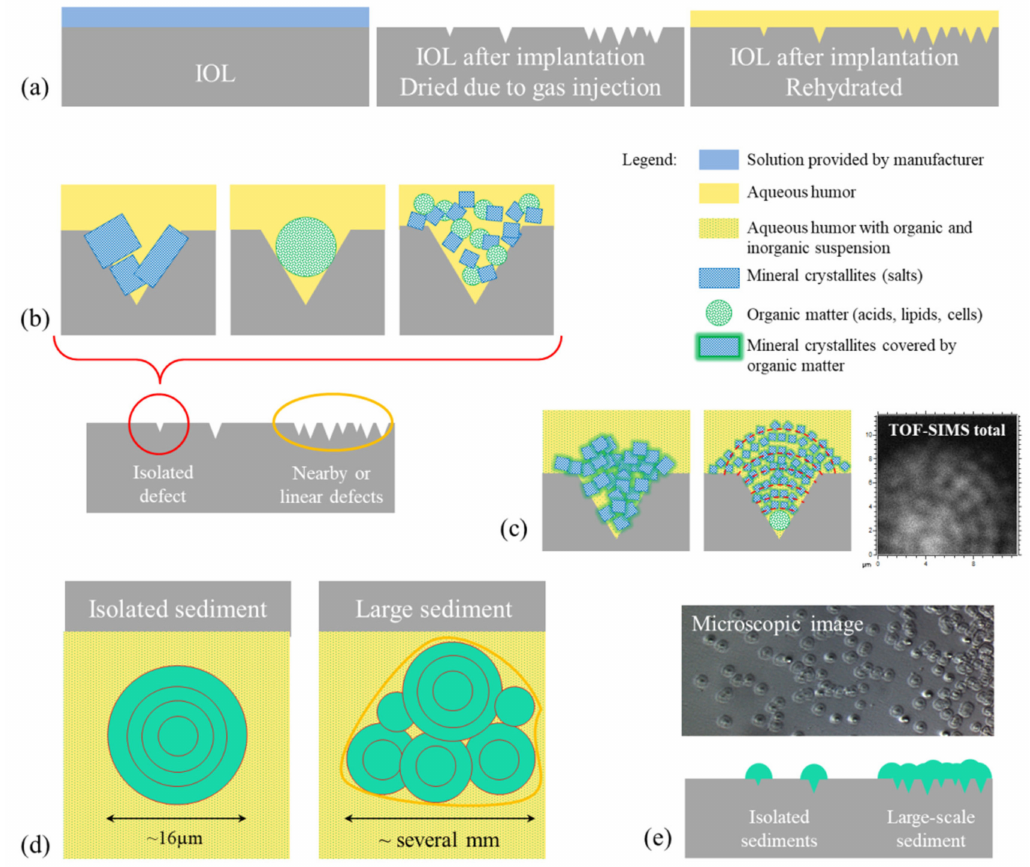
Figure 9. Diagrams illustrating the probable mechanism of sediment formation on IOL surface. ( a ) Scheme of lens cross sections at di ff erent stages presented in the following order: stored in the liquid foreseen by the manufacturer, after contact with the air bubble after DSAEK procedure, and after rehydration in eye. The probable origins of stages of sediment growth are shown ( b ) based on the literature and ( c ) proposed in this work. The sediment expansion was illustrated on scheme ( d ) top view and ( e ) cross-section view, combined with microscopic image and TOF–SIMS distribution maps of all detected